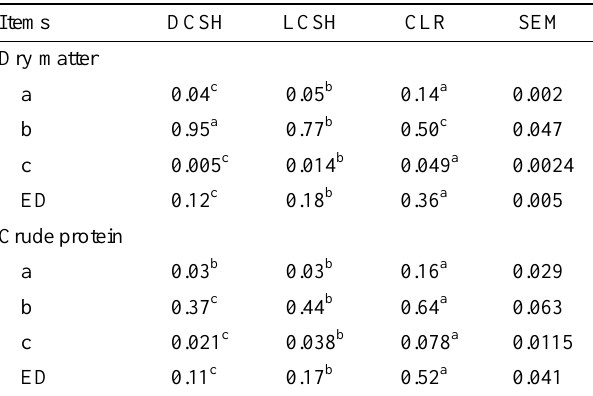
Table 3 . In situ dry matter and crude protein degradation kinetics of delinted cottonseed hulls (DCSH), linted cottonseed hulls (LCSH) and cottonseed linter residue (CLR)